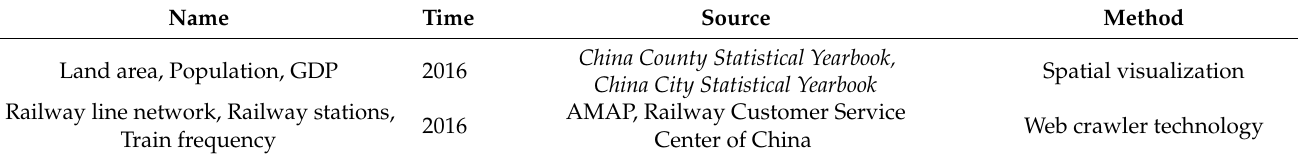
Table 1. The data base of this